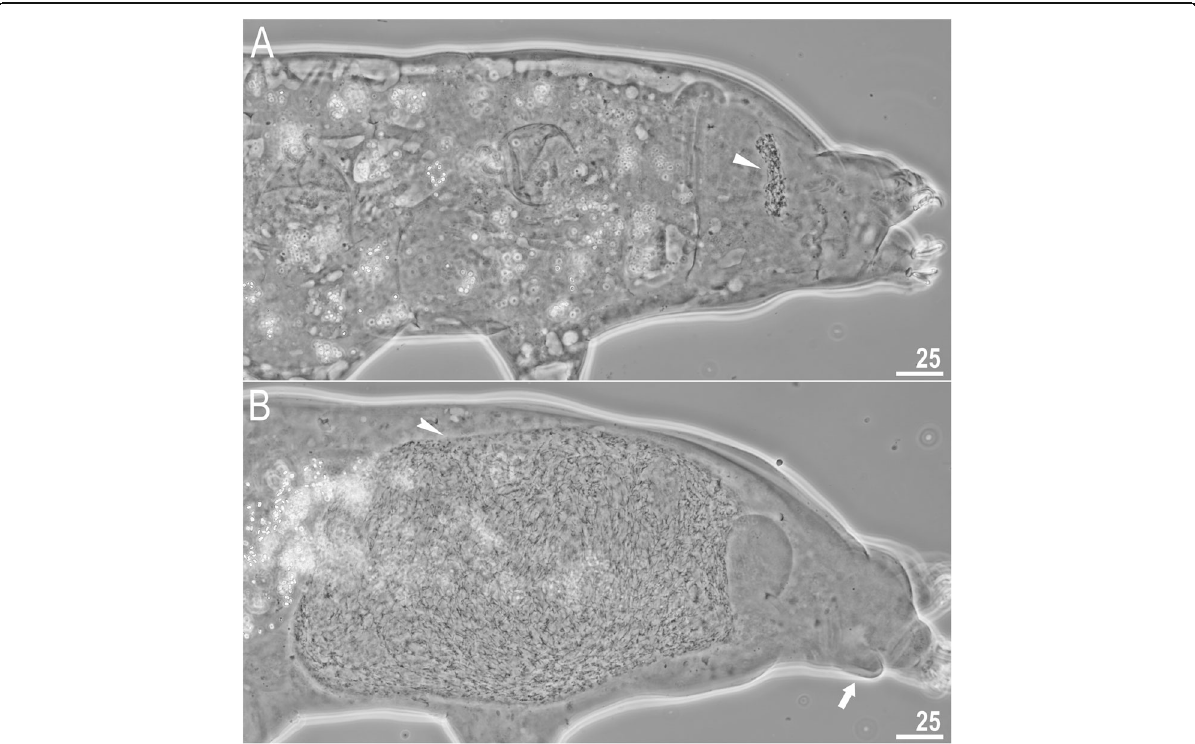
Fig. 11 Macrobiotus pallarii Maucci, 1954 from the topotypic population (IT.337) – reproduction (LCM): a – spermatheca (seminal vesicle) filled with spermatozoa and visible in females freshly mounted in Hoyer ’ s medium; b – testis filled with sperm visible in a male freshly mounted in Hoyer ’ s medium. The flat arrowhead indicates the female spermathecae, the indented arrowhead indicates the testis, and the arrow indicates the gibbosity on the IV leg. Scale bars in μ